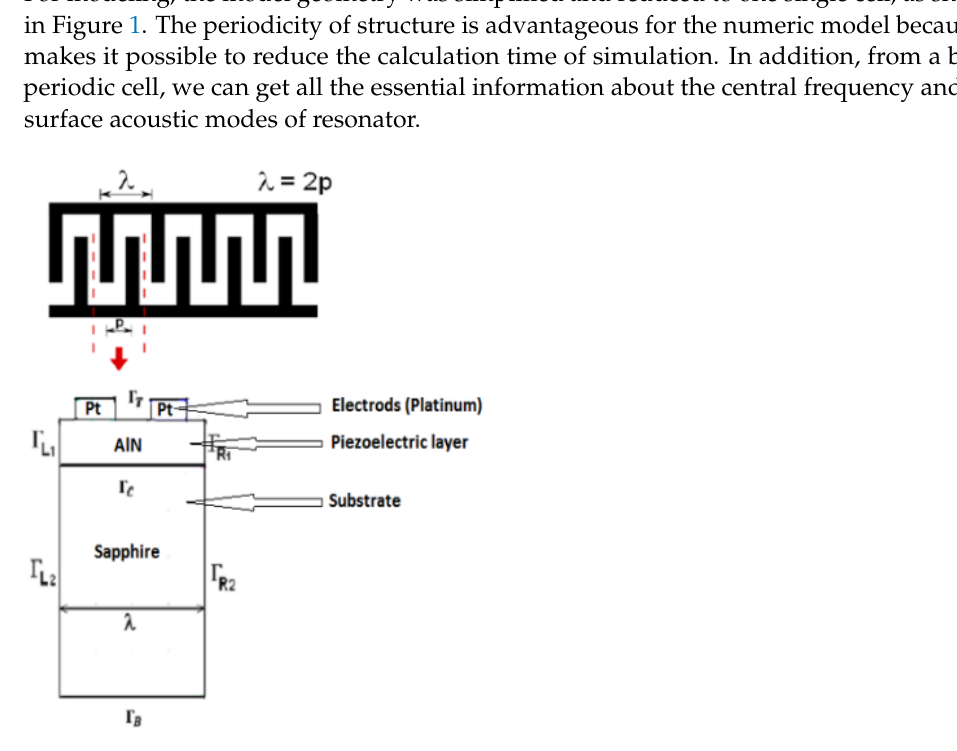
Figure 1. Model geometry of structure and schematization of one periodic cell for modeling.